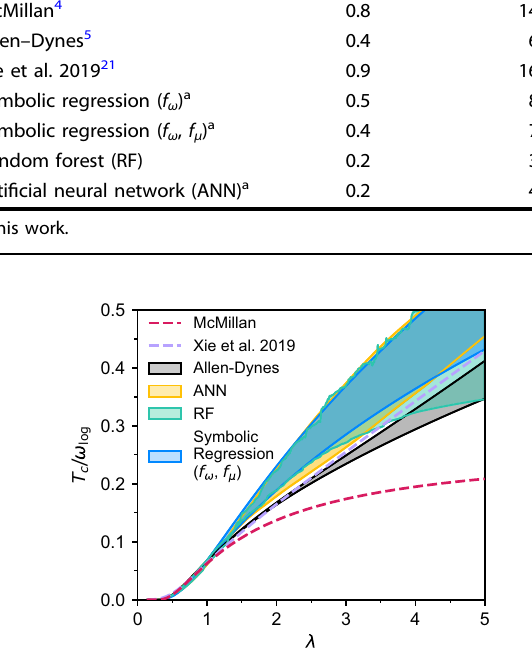
Fig. 6 Dependence of T c on λ for select predictive models. The McMillan and Xie at al. (2019) equations, which do not change with = ω – Dynes formula ω log 2 , are depicted as dashed curves. The Allen and the ANN, RF, and symbolic regression machine learning corrections from this work are plotted as shaded regions bound by ω log = ω 2 ¼ 1 : 1 and ω log = ω 2 ¼ 1 : 6 curves. All models behave similarly for low to moderate values of λ . For larger values of λ , the ANN, RF, and symbolic regression corrections deviate signi fi cantly from the Allen – Dynes equation as well as the previous symbolic regression equation. The RF regression exhibits discontinuities due to its piecewise-constant